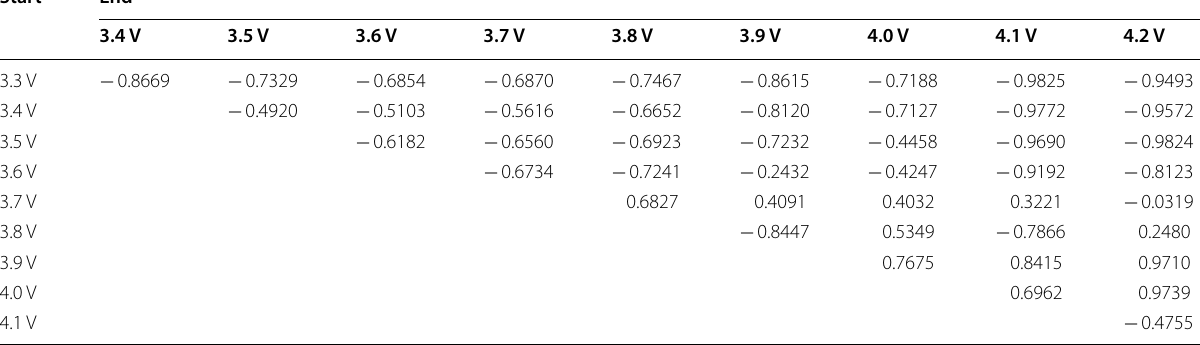
Table 3 VQA correlation analysis of different voltage intervals Start